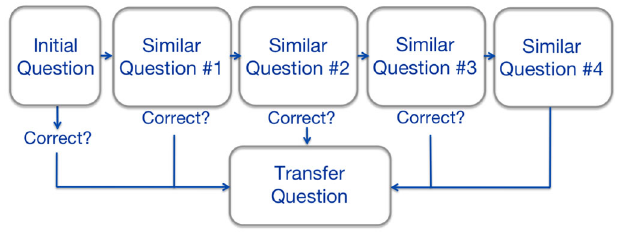
FIG. 5 (color online). Flow chart showing how the initial problem, similar problems, and transfer problems were admin- istered to students in each of four problem